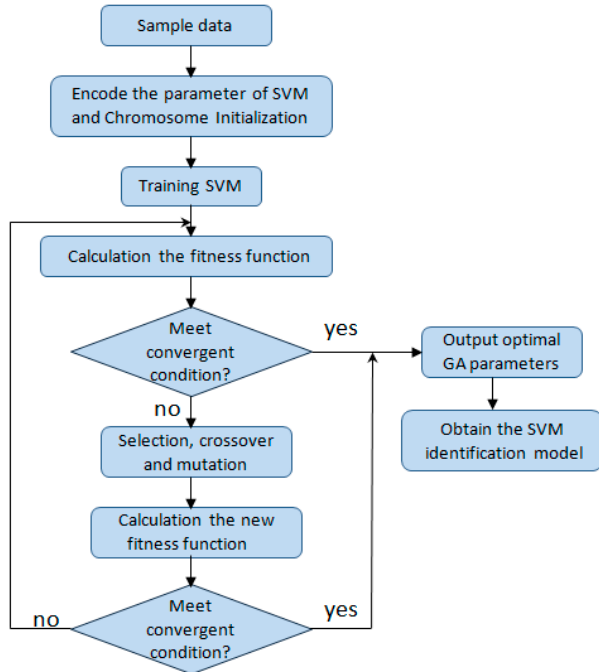
Figure 4. GA-SVM algorithm flowchart.